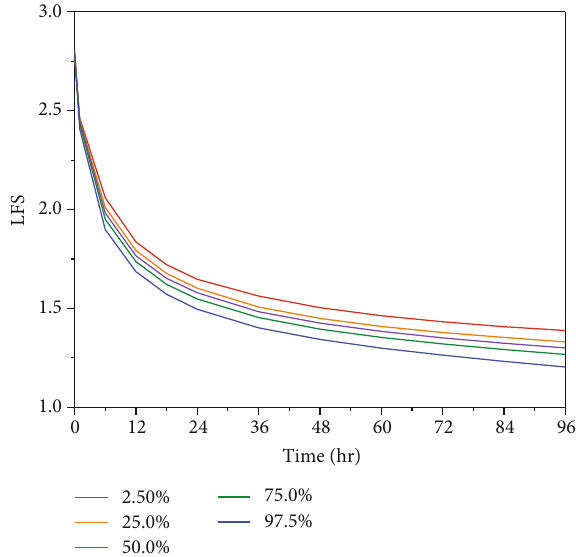
Figure 13: Local factor of safety at the observation pro fi le with di ff erent percentiles of the